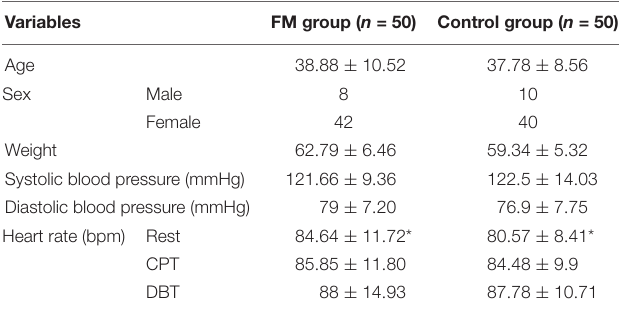
Data are expressed as mean ± SD. Statistics: Mann–Whitney U-test for all parameters except sex; for sex, chi-square test. FM, fibromyalgia; CPT, cold pressor test; DBT, deep breathing test. * p <